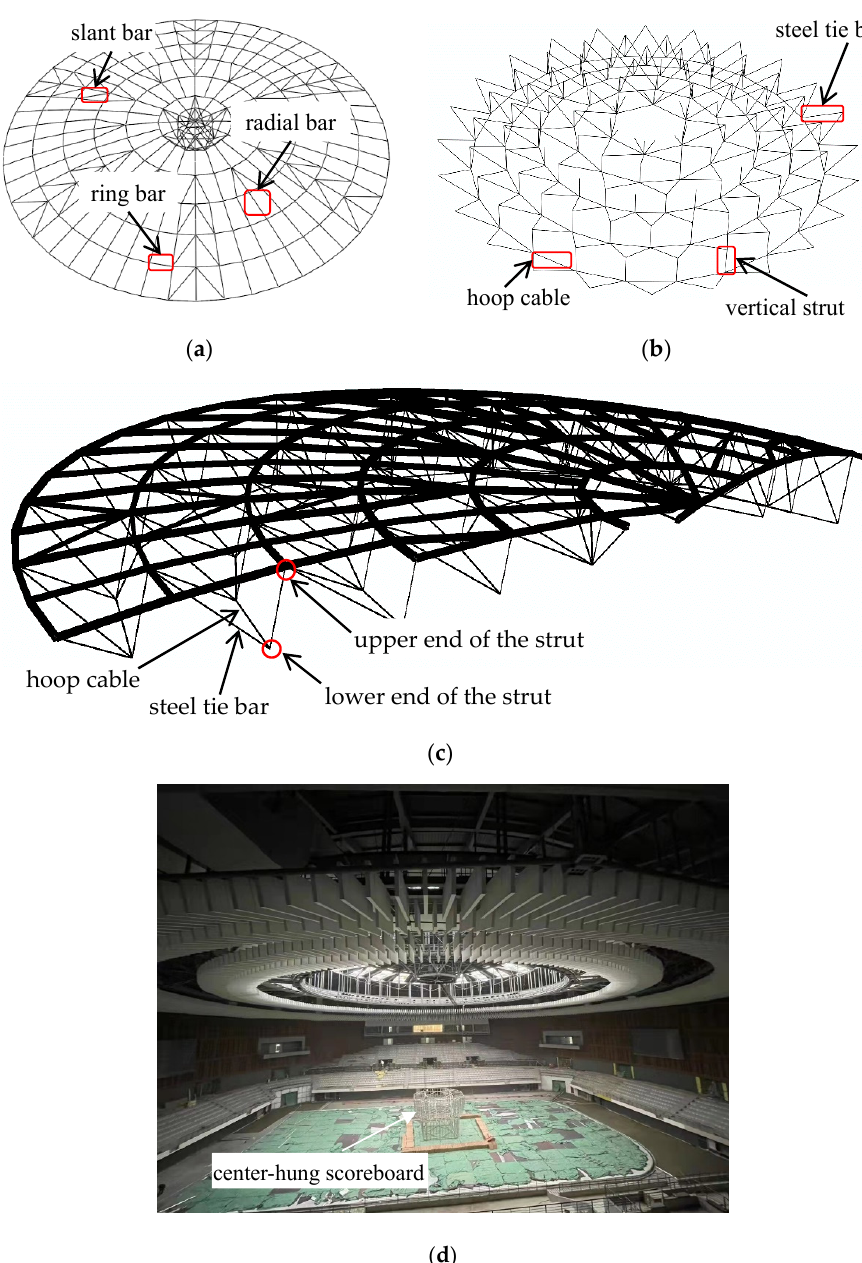
Figure 3. The Gymnasium of Lanzhou Olympic Sports Center.